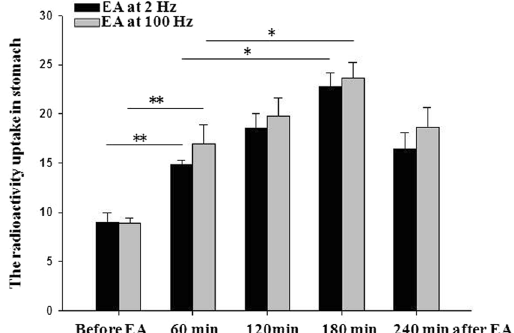
Figure 4. Compared with pre-EA, the radioactivity uptake in the stomach was significantly increased during 2 Hz-EA. The up-regulation escalated gradually and did not reach the peak until 180 minutes after the EA. The stomach uptake started to decrease 3 hours after 2 Hz EA at ST 36. 100 Hz-EA appeared to induce more radioactivity uptake than did 2 Hz EA in the stomach; however, no significance was reached in comparison of the two groups. Compared with radioactivity uptake in the stomach during EA, * p < 0.05, ** p < 0.01, Two-way ANOVA followed by Duncan post hoc